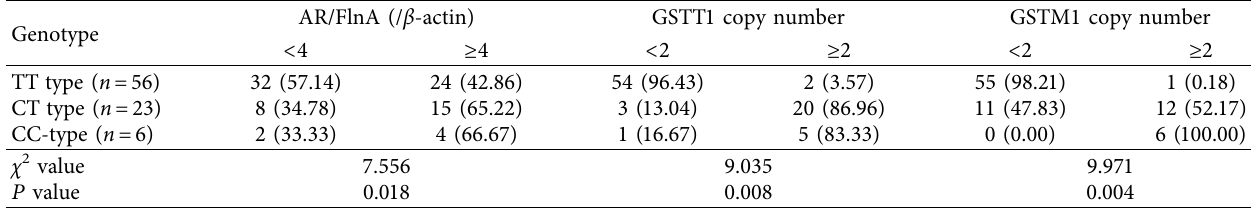
Table 6: Comparison of AR/FlnA expression and copy number of GST gene in diferent genotypes of prostate cancer patients at rs5918762